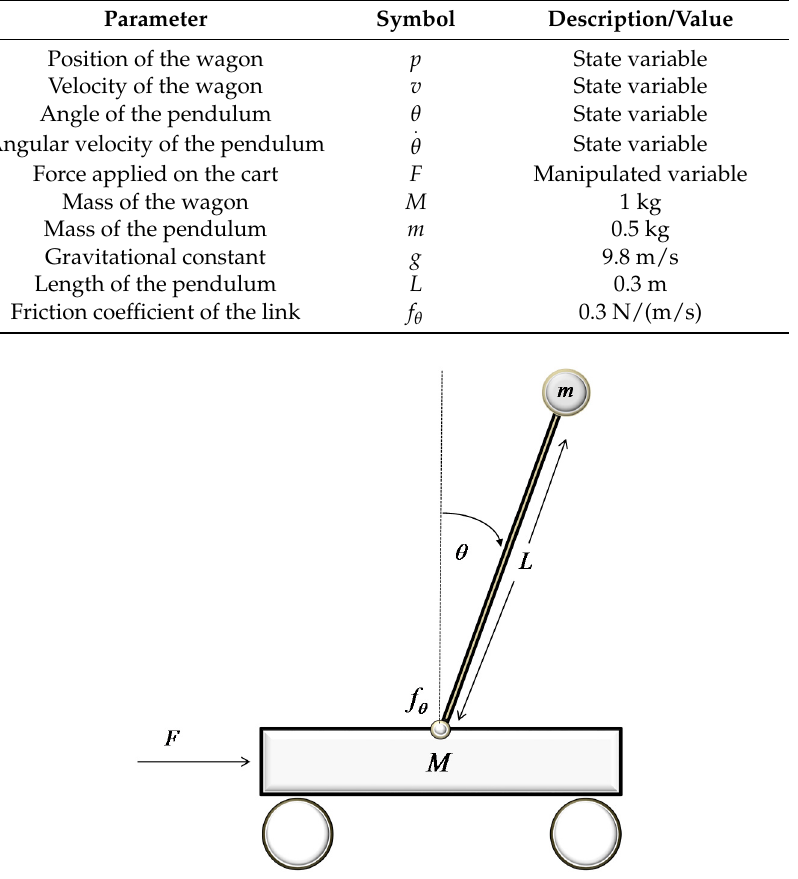
Table 4. Notation and parameter values for the inverted pendulum.